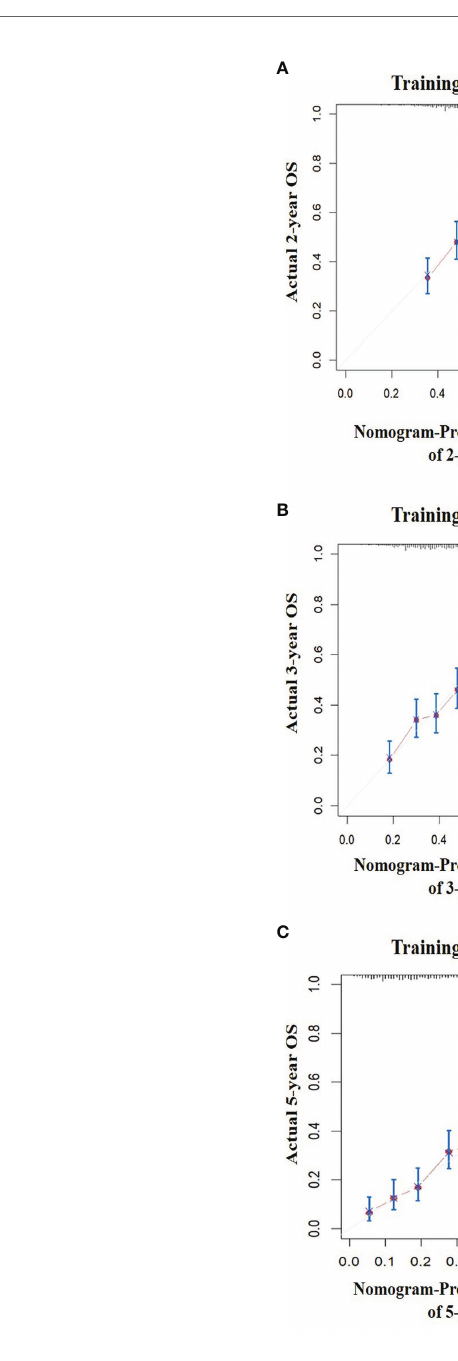
result and reported outcomes may be caused by the difference in guideline recommendations and real-world clinical practices.